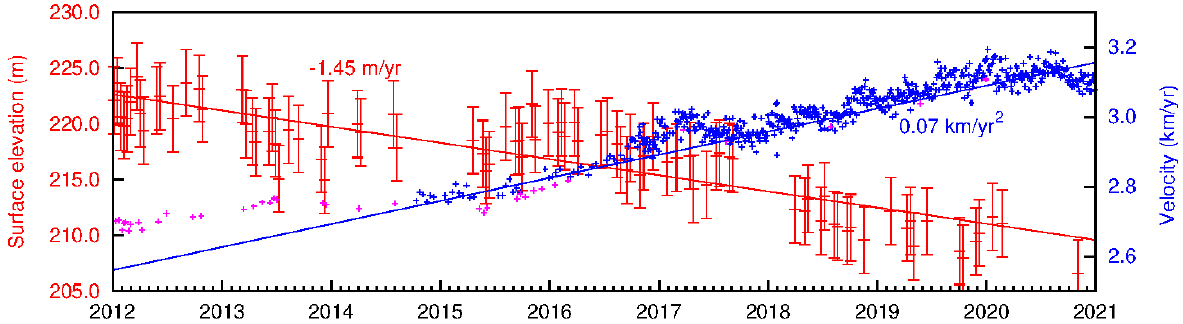
Figure 3. Time series of heights (relative to the EGM2008 geoid; Pavlis et al., 2012) and surface speeds extracted at the point marked by the star in Fig. 1c. Vertical bars on the elevation points represent the ± 2m estimated error. Magenta crosses represent the TerraSAR-X speeds, and blue crosses represent the Sentinel-1